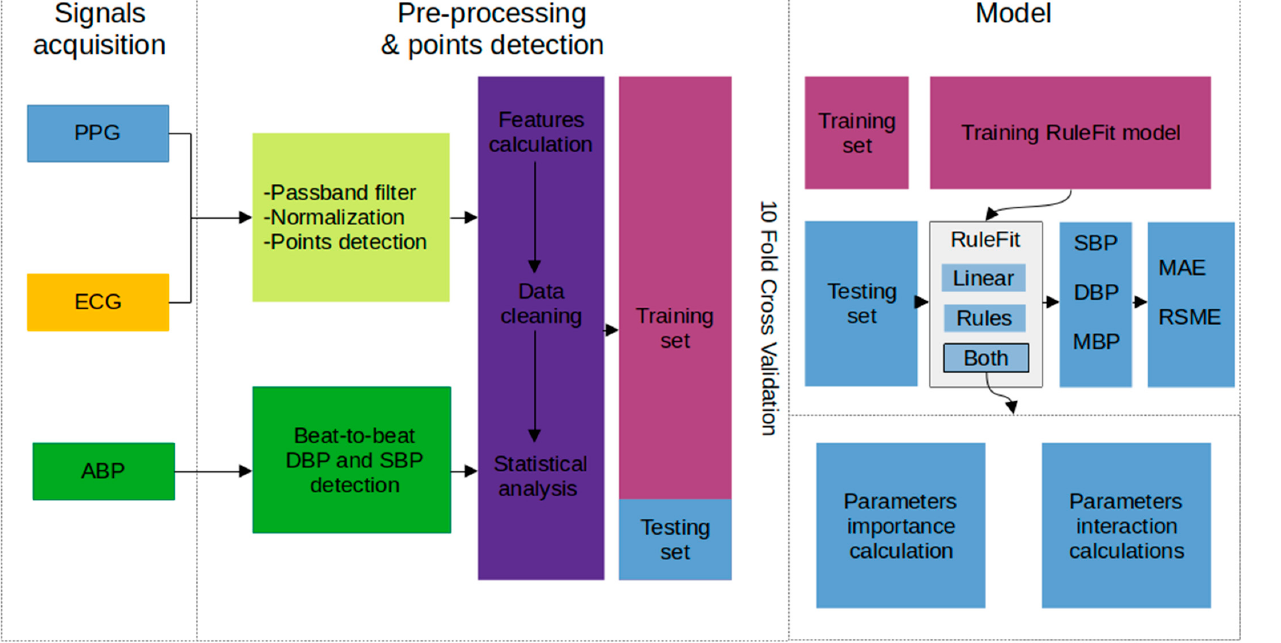
Figure 1. Flow chart of the experiments based on the RuleFit model. The same process was performed during rest and the weight-bearing test. Statistical analysis was done by comparing both data sets. PPG, photoplethysmography; ECG, electrocardiogram; ABP, arterial blood pressure signal; DBP, diastolic blood pressure; SBP, systolic blood pressure; MBP, mean blood pressure; MAE, mean absolute error; RMSE, root mean square error.